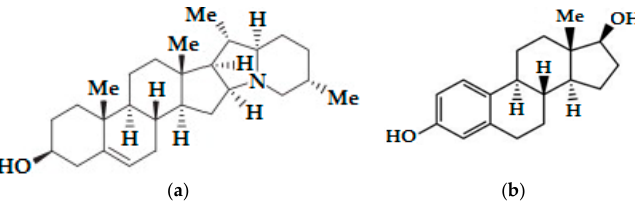
Figure 1. Structural similarities of the potato aglycone solanidine to the estradiol: ( a ) The molecular structure of solanidine; ( b ) The molecular structure of estradiol .